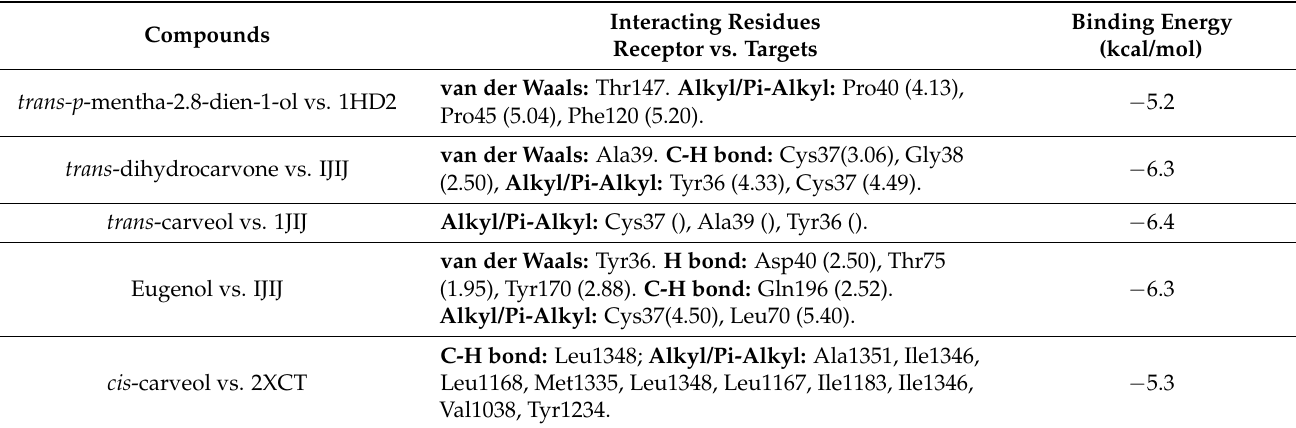
Figure 10. Two-dimensional (2D) and three-dimensional (3D) residual interactions network of carvone ( A , B ), and limonene ( C , D ) with the active site of CviR enzyme (PDB ID, 3QP1). Table 6 summarizes the best-identified bioactive compounds in caraway essential oil with all target proteins, their interacting residues, and binding energies (Kcal/mol). Table 6. Best phytoconstituents with the lowest binding energies and their interaction residues with selected target